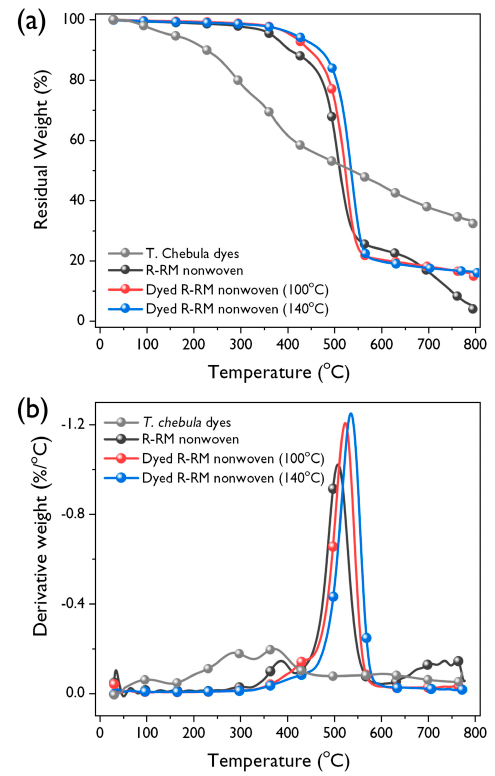
Figure 10. ( a ) TGA thermograms of and ( b ) derivative curves of T. chebula dye, R-RM nonwoven, R-RM nonwoven dyed at 100 °C , and R-RM nonwoven dyed at 140 °C . Table 4. Thermal degradation parameters of the T. chebula dye and dyed R-RM nonwoven.